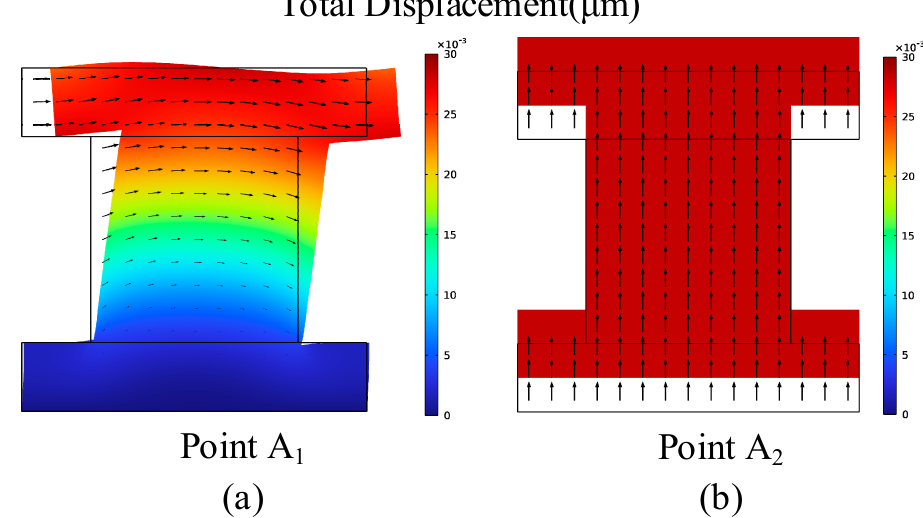
Figure 5. The eigenmodes and the displacement vector fields of the special points.